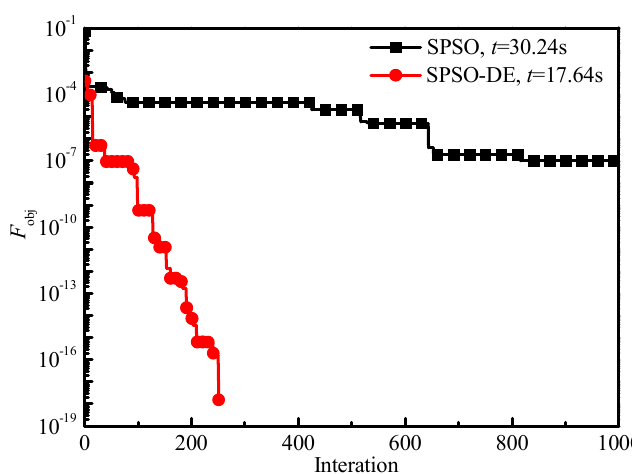
Figure 4. Comparison of objective function values of SPSO and hybrid SPSO-DE algorithms in retrieving monomodal Gamma distribution.